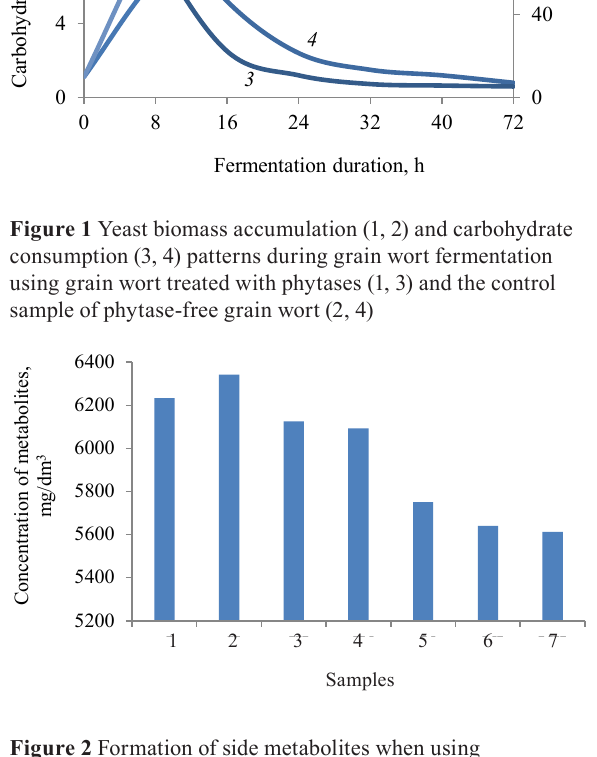
Figure 2 Formation of side metabolites when using glucoamylase preparations derived from recombinant strains of Aspergillus awamori